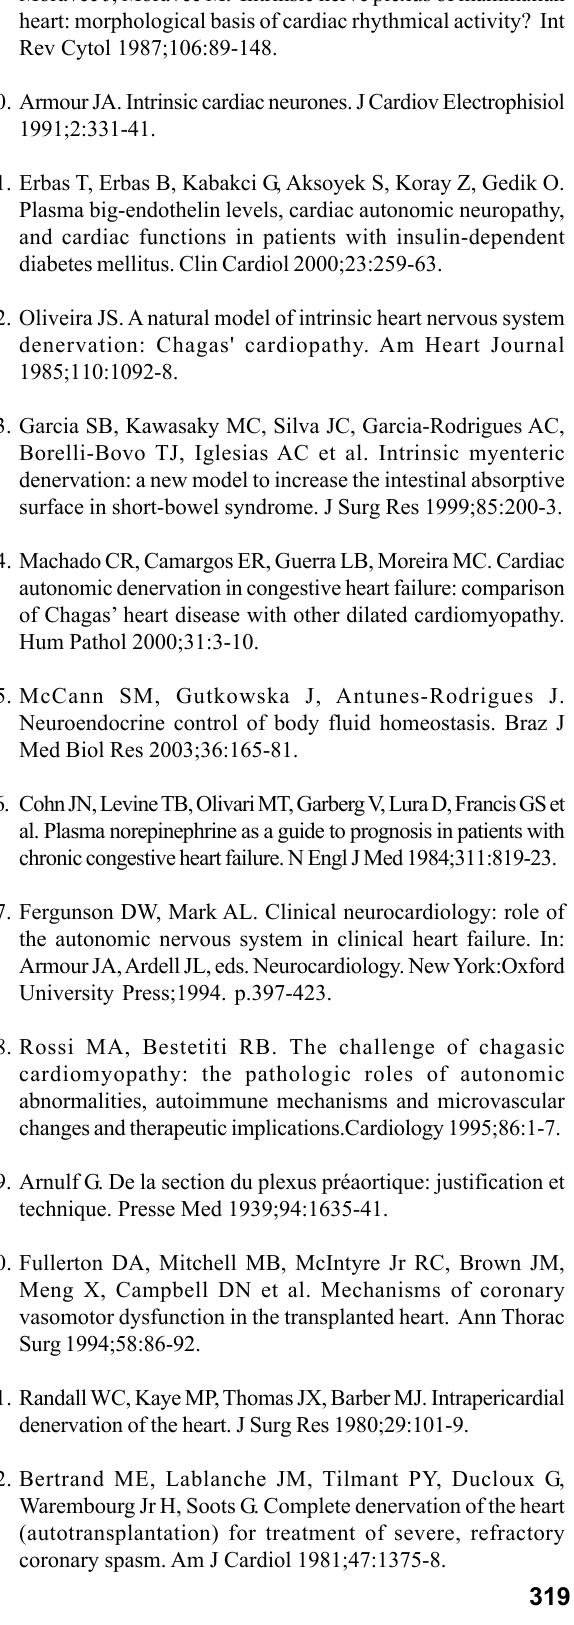
1. Gray AL, Johnson TA, Ardell JL, Massari VJ. Parasympathetic control of the heart. II. A novel interganglionic intrinsic